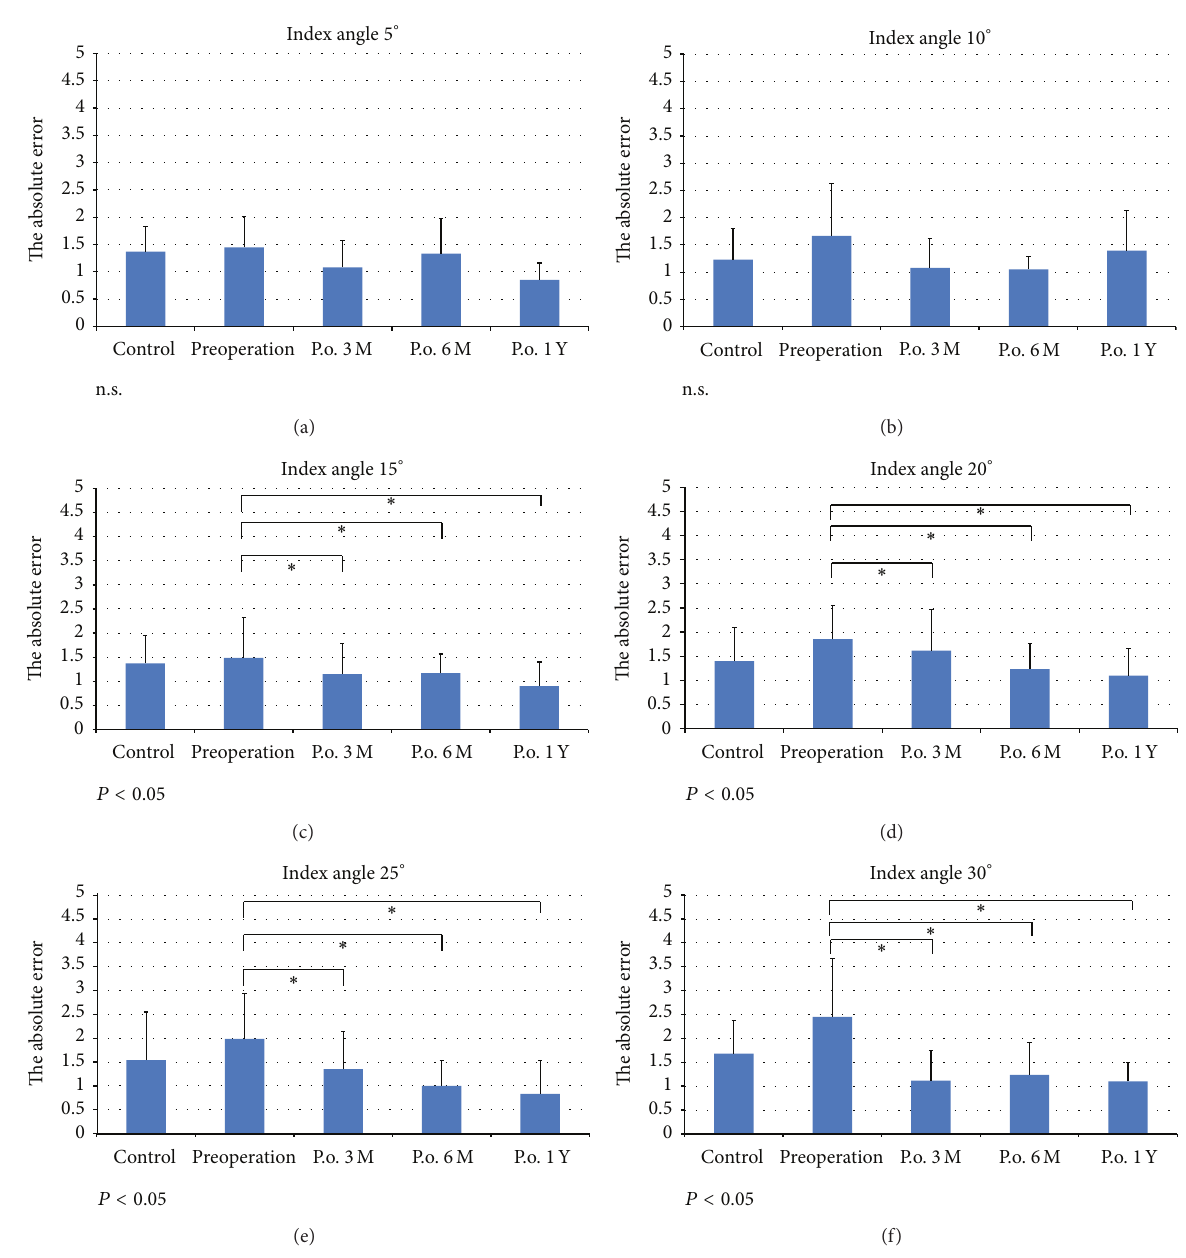
Figure 3: Joint position sense angles over the 1-year follow-up period. (a) and (b); there were no significant differences in the degree of error of joint position sense between control groups and unstable groups at index angle 5 ∘ and 10 ∘ . (c), (d), (e), (f); these values were significantly different from those found preoperatively for all index angles over 15 ∘ ( 𝑃 < 0.05 ). And there was no significant difference in the absolute error between 3 months, 6 months, and 1 year after